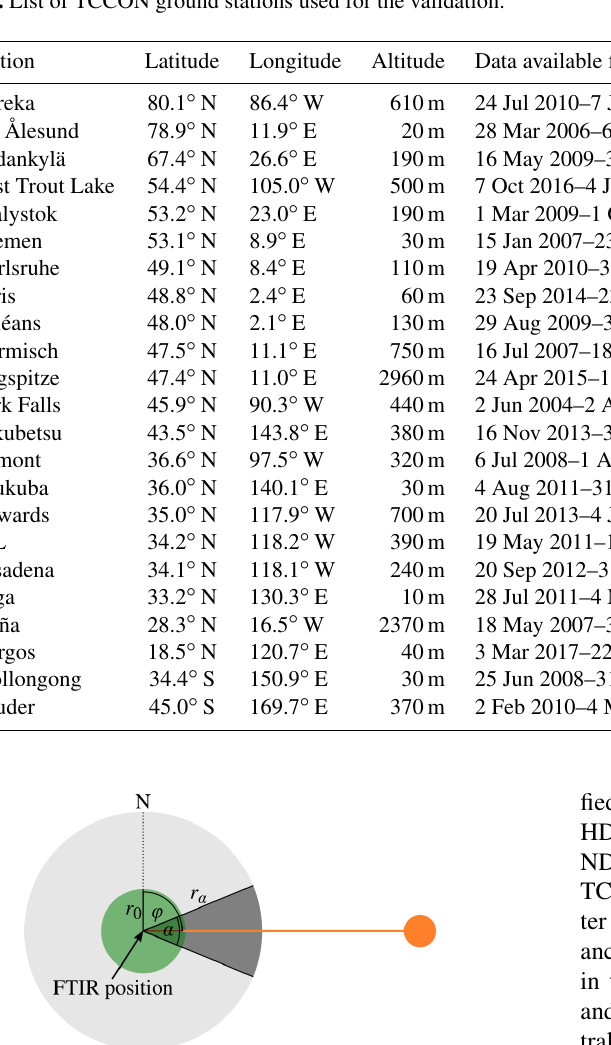
Table 2. List of TCCON ground stations used for the validation.